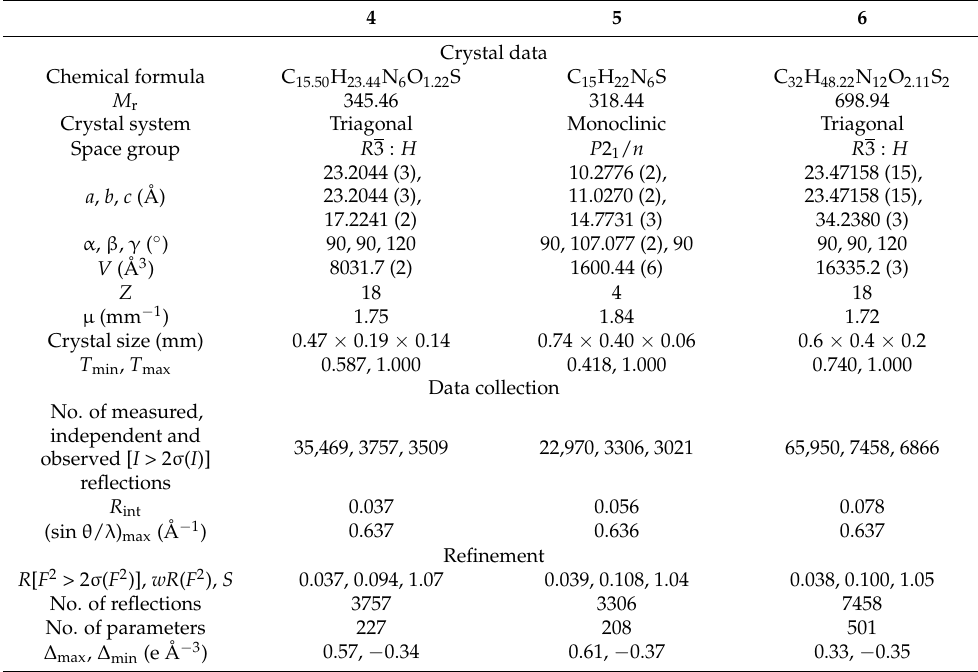
Table 4. Crystal data, data collection, and refinement details of compounds 4 – 6 .